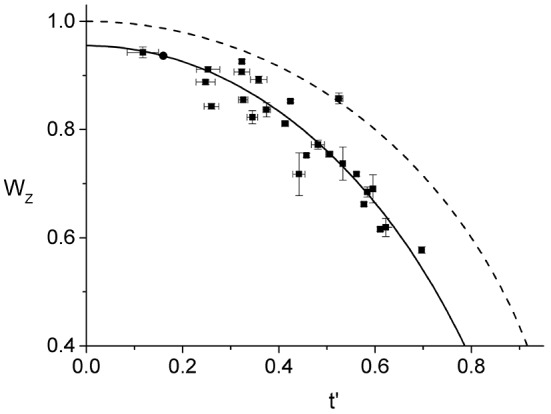
Effective dynamics of the Z-ring constriction, Wz(t′) (squares with error bars). We use the same data set as in Figure 3, only here the normalized radius of the Z-ring is plotted as a function of the effective division time. The prediction of Equation (1) (dashed line) together with the curve corresponding to the linear fit in Figure 3 (full line) are also shown.